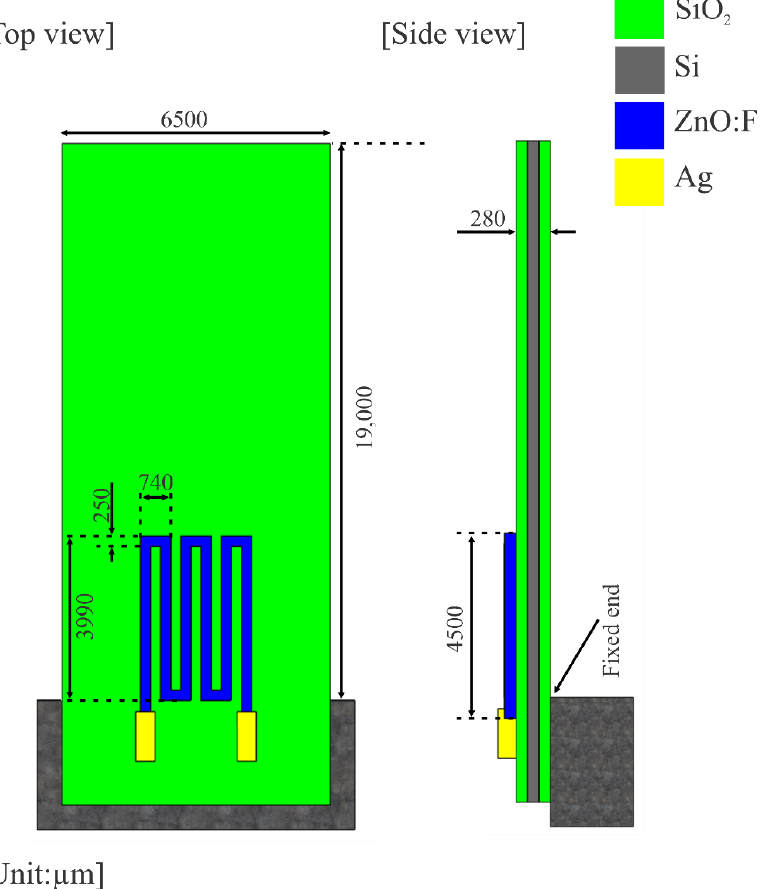
Figure 2. Cantilever device design with ZnO:F piezoresistor. The characterization of the change in the resistance of the ZnO:F piezoresistor caused by strain was carried out using a Keithley model 2400 source-Meter with a precision of 6.5 digits, and the cantilever method. The test consisted of fixing one end of the rectangular silicon substrate, where the piezoresistor is located next to it, while different masses were placed on the free end to cause deflection in the cantilever structure (see Figure 3).